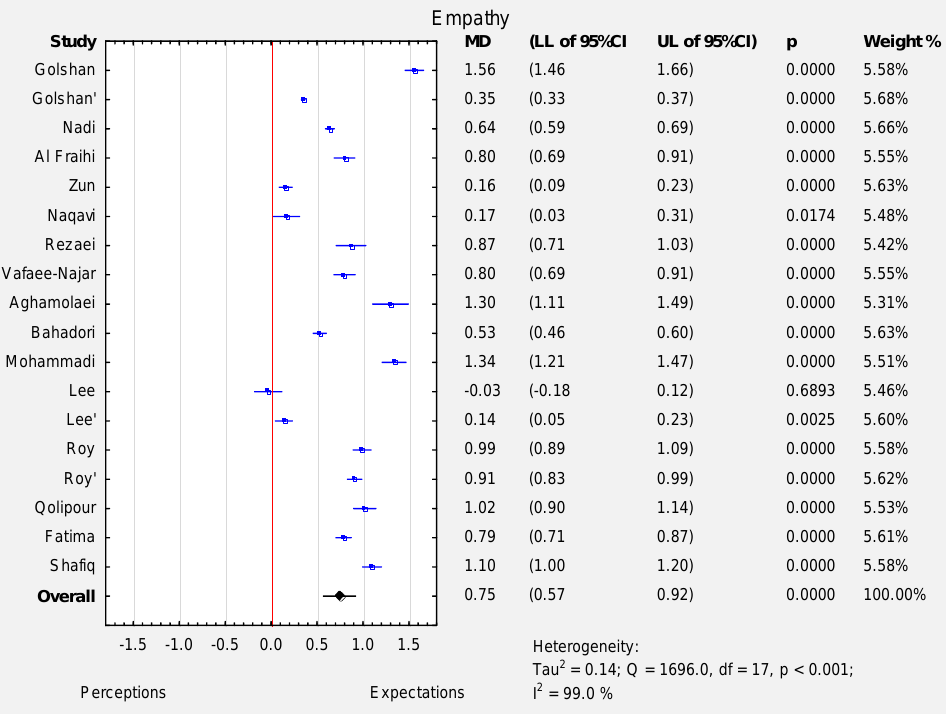
Figure 6. Forest plot for the mean difference ([MD]; 95% CI) of the patients’ perceptions and expec- tations in the empathy dimension. The pooled estimated MD for tangibility and reliability was 0.82 (95% CI: 0.62, 1.01) and 0.82 (95% CI: 0.60, 1.03), respectively. The gap between the expectations and the per- ceptions was the lowest for empathy [0.75 (95% CI: 0.57, 0.92)] (see Figure 7). The funnel plot and the results of Egger’s test ( Supplementary Materials) indicate no evidence of pub- lication bias in some studies (t = 0.58, p < 0.62).